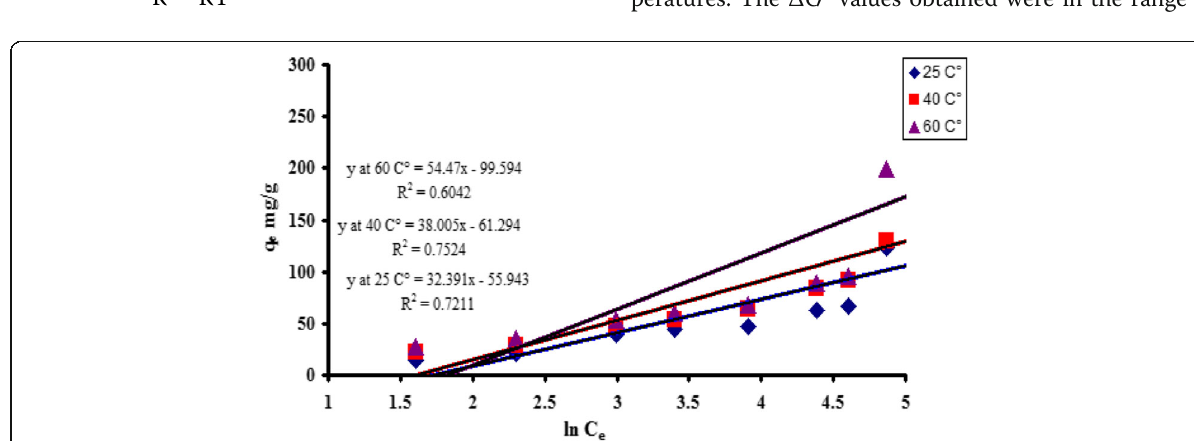
Fig. 19 Temkin isotherm model plot at different